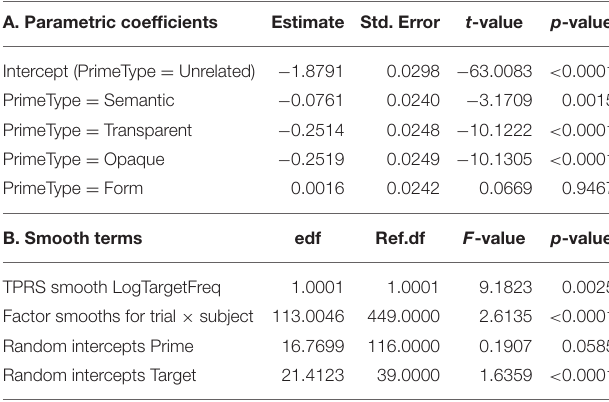
TABLE 2 | Generalized additive mixed model fitted to inverse-transformed primed lexical decision